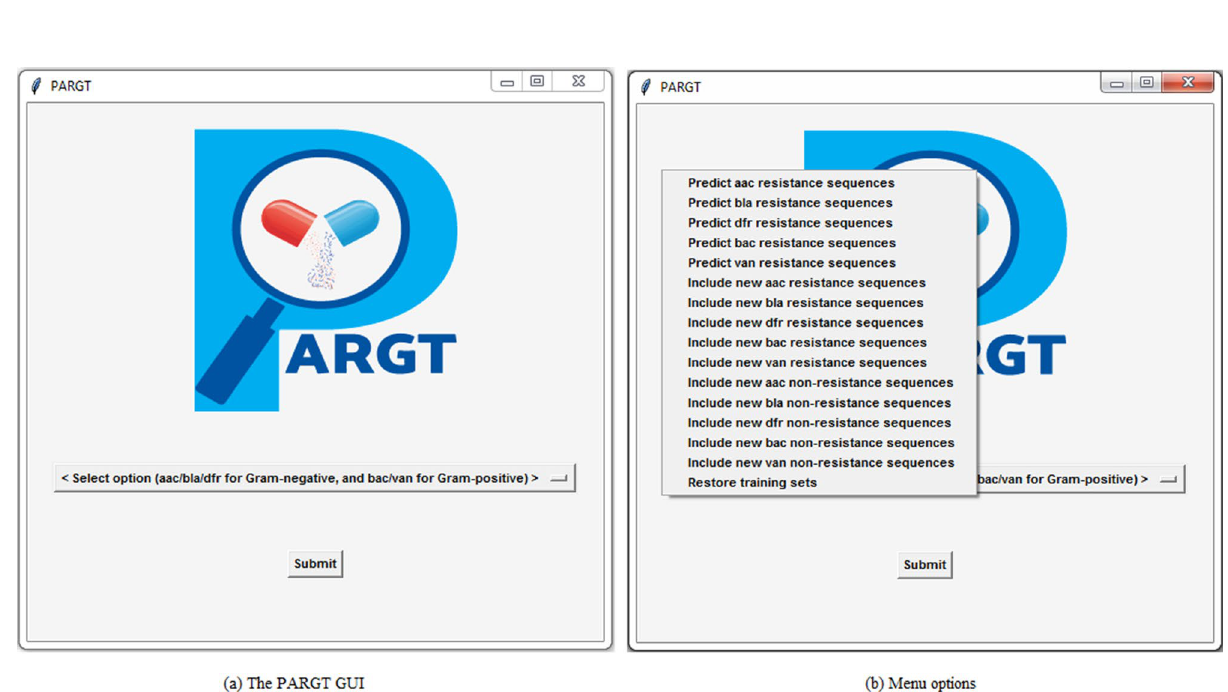
Figure 2. Illustration of the PARGT GUI with its pop-up